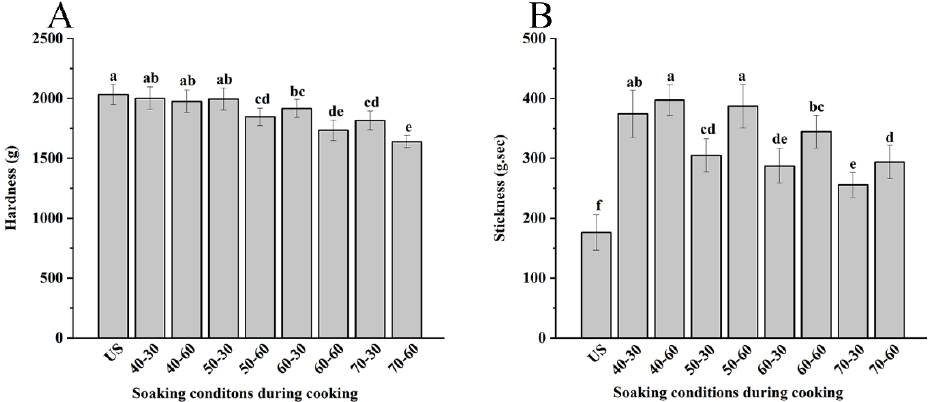
Figure 1. The hardness ( A ) and stickiness ( B ) of cooked brown rice under different soaking conditions. “US” respected unsoaked brown rice; soaking conditions such as “40-30” respected soaking at 40 °C for 30 min. Results with different lowercase letters are significantly different ( p < 0.05).